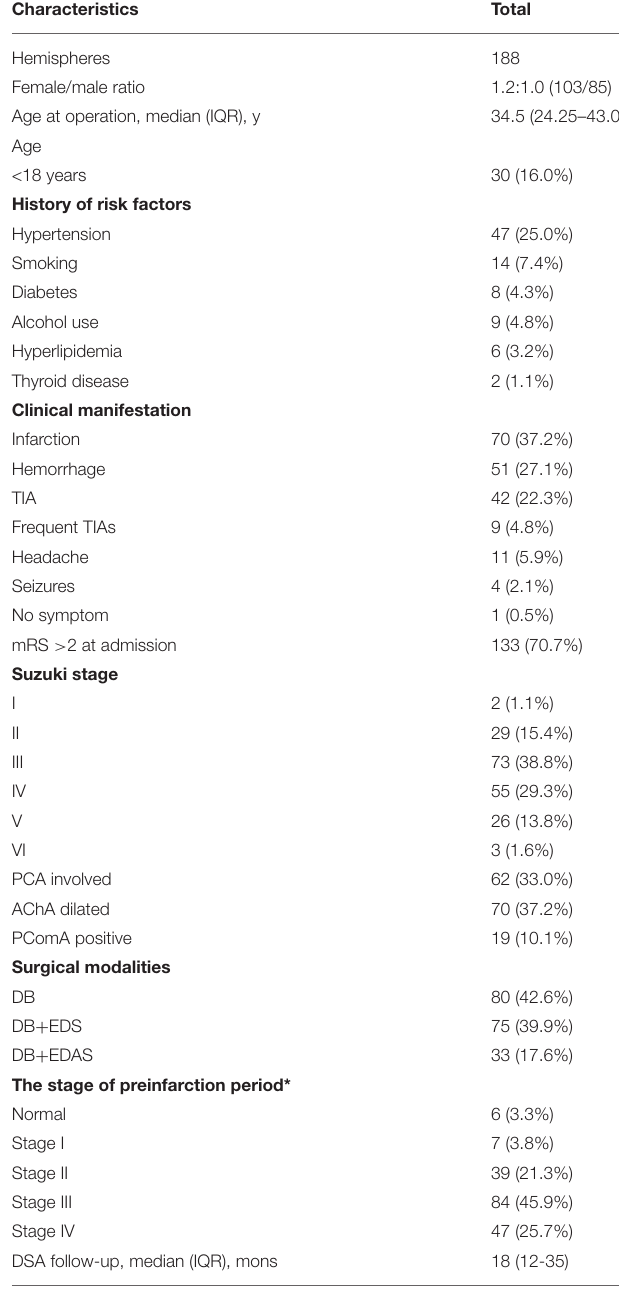
TABLE 1 | Clinical characteristics of 188 hemispheres in this